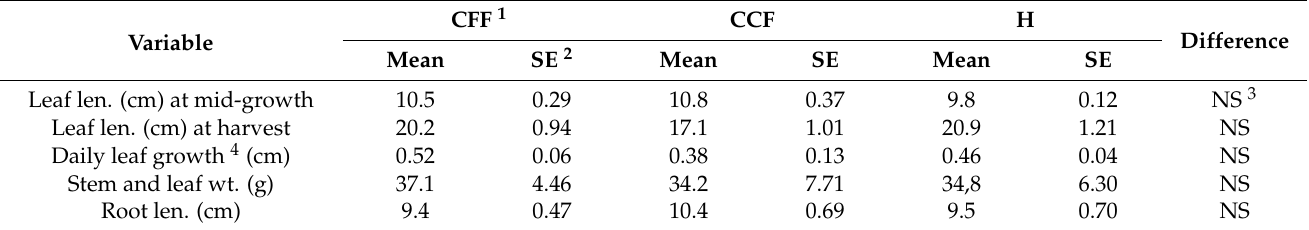
Table 3. Lettuce growth among systems with three different fish food